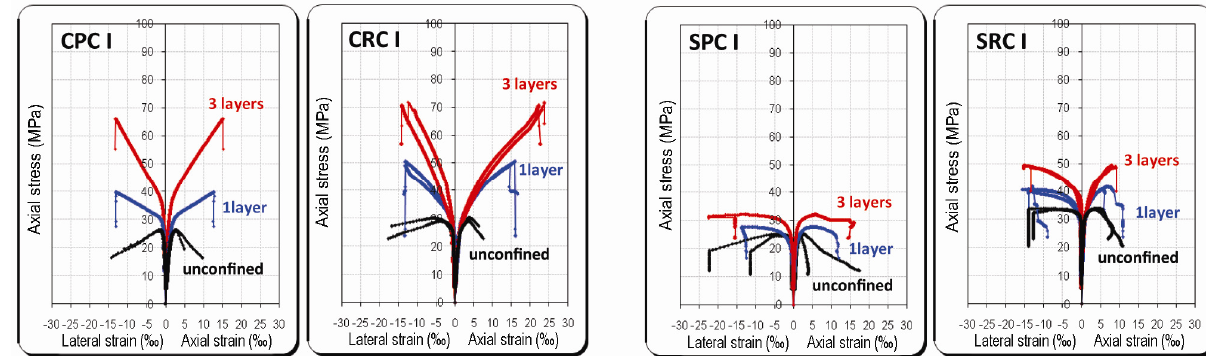
Fig. 8. Experimental stress strain curves of normal-strength concrete specimens ( f’ co = 26 MPa)